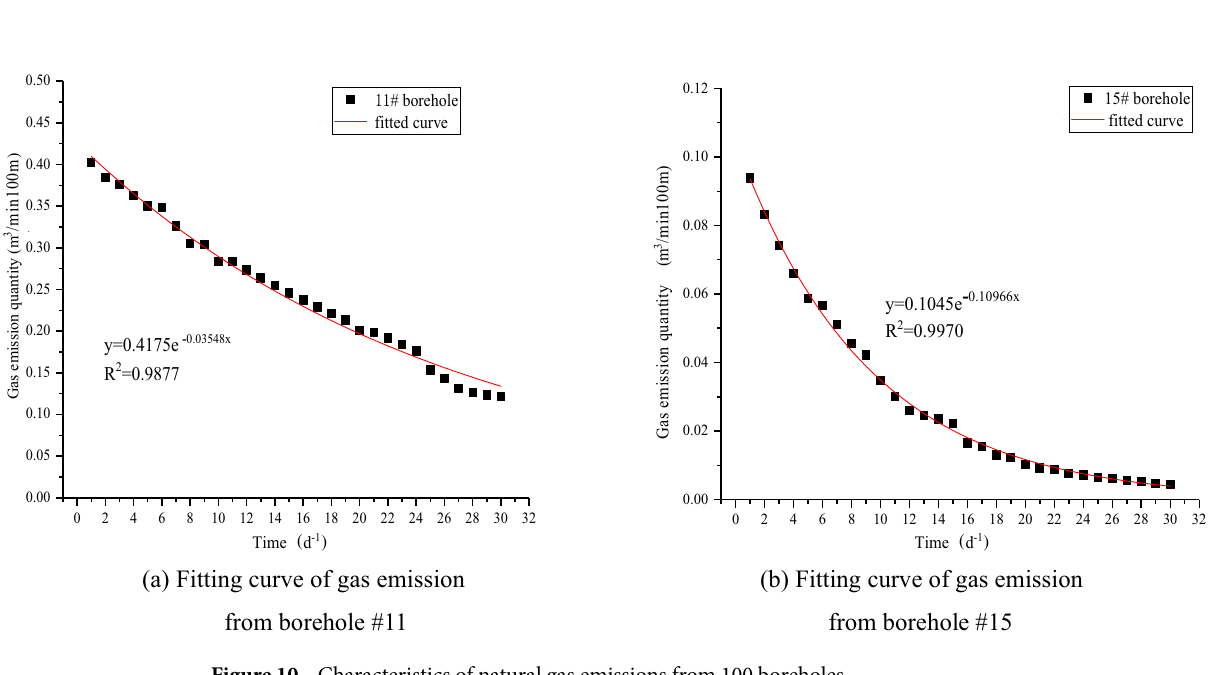
Figure 10. Characteristics of natural gas emissions from 100